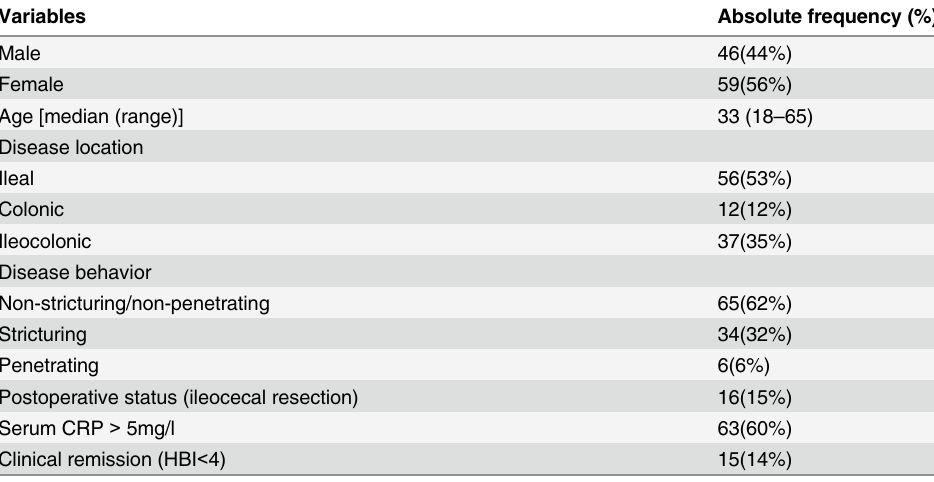
Table 2. Baseline demographic and clinical characteristics of the CD patients (n =